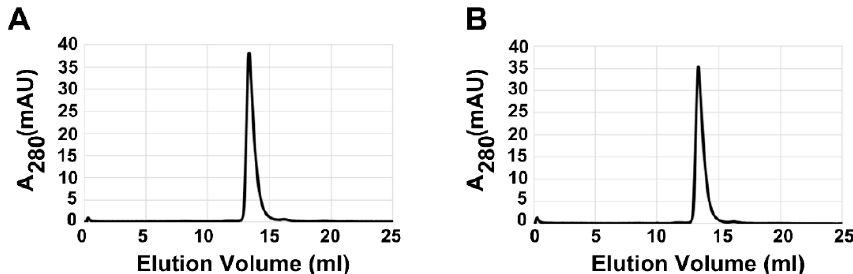
Figure 8. Gel filtration analysis of the global fold of AbPPase. ( A ) Gel filtration profile of AbPPase in the presence of 1.6 mM PPi and 1.6 mM MgCl 2 . The elution peak of AbPPase falls at 13.36 mL. ( B ) The gel filtration profile of AbPPase in the presence of 200 mM NaCl,1.6 mM PPi and 1.6 mM MgCl 2 . The elution peak of AbPPase falls at 13.32 mL.